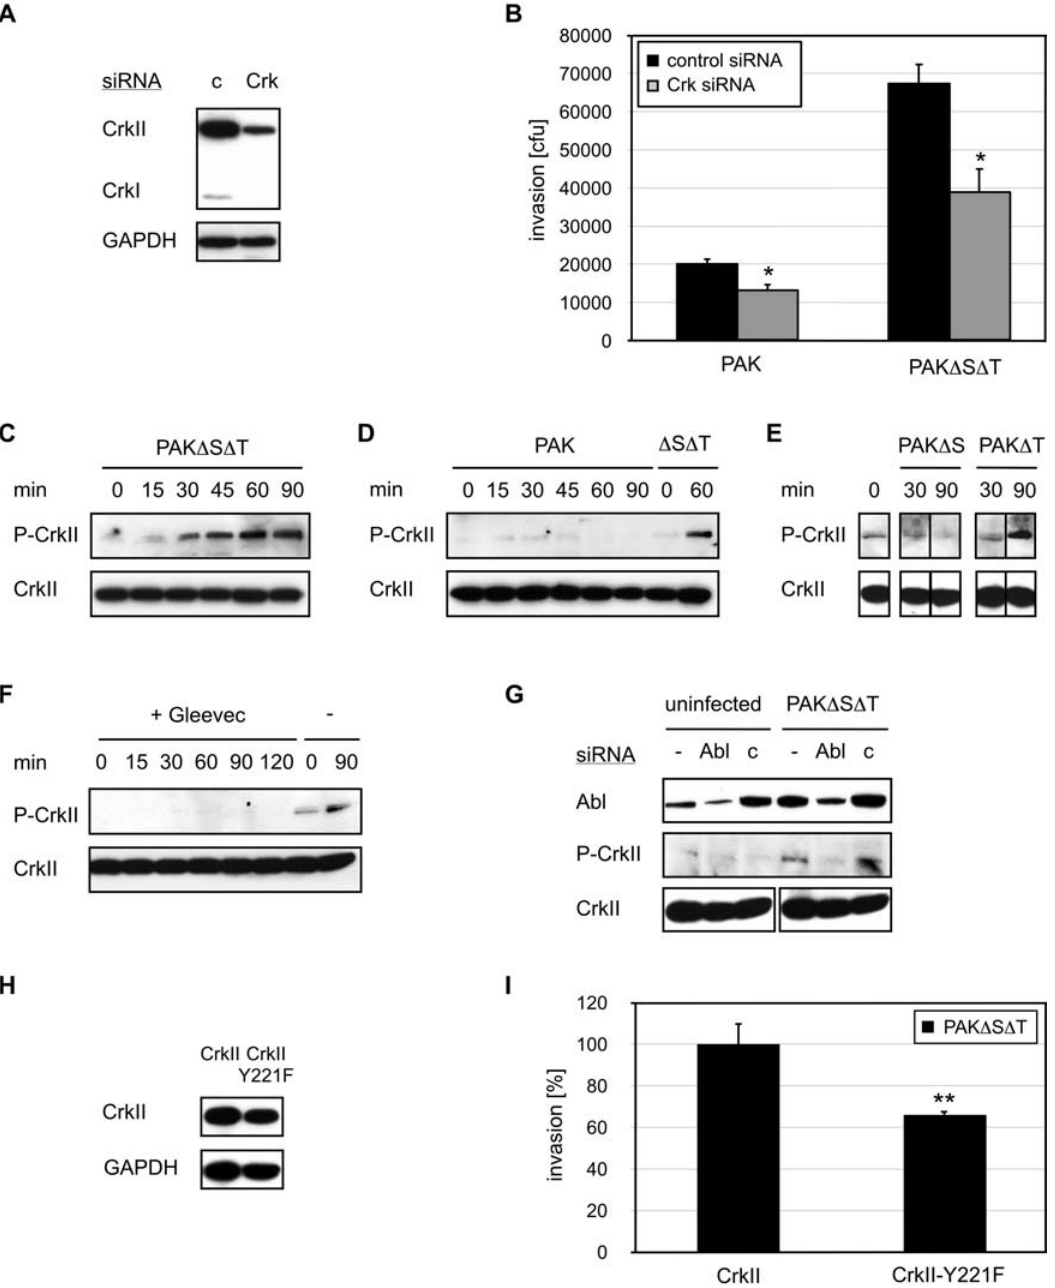
Figure 3. Abl-dependent Crk phosphorylation is required for P.aeruginosa invasion. (A) HeLa cells were treated with Crk or control (c) siRNA and cell lysates were immunoblotted with an anti-CrkI/II-antibody. GAPDH was used as loading control. (B) Standard invasion assays were used to quantify the effect of Crk or control siRNA treatment of invasion of PAK or PAK D S D T at 1 h into HeLa cells. *p , 0.05 compared to control RNA- treated cells. (C–E) HeLa cells were infected with the indicated strains for the indicated times, lysed and immunoblotted with anti-phospho-CrkII- Y221 and anti-CrkI/II. (F, G) HeLa cells were infected with PAK D S D T for indicated times in the presence of 30 m M Gleevec (F) or after treatment with Abl or control siRNA (G) and cell lysates were immunoblotted with anti-phospho-CrkII-Y221 and anti-CrkI/II. (H) HeLa cells were transfected with pCAGGS-CrkII and pCAGGS–CrkII-Y221F for 16 h and cell lysates were immunoblotted with an anti-CrkI/II antibody. GAPDH was used as loading control. (I) Standard invasion assays were used to quantify the effect of over-expression of CrkII or CrkII-Y221F on invasion of PAK D S D T at 1 h into HeLa cells. **p , 0.01 compared to cells over-expressing wild type CrkII. doi:10.1371/journal.ppat.1000031.g003 interfere with Crk function. Indeed, infection with isogenic PAK To further test whether Abl is responsible for the phosphory- lation of CrkII upon infection with P. aeruginosa , HeLa cells were mutants lacking either ExoT or ExoS revealed that ExoT was responsible for the inhibition of PAK D S D T-induced CrkII either treated with the Abl kinase inhibitor Gleevec (Figure 3F) or phosphorylation (Figure 3E). depleted of Abl by siRNA (Figure 3G). Either treatment abrogated